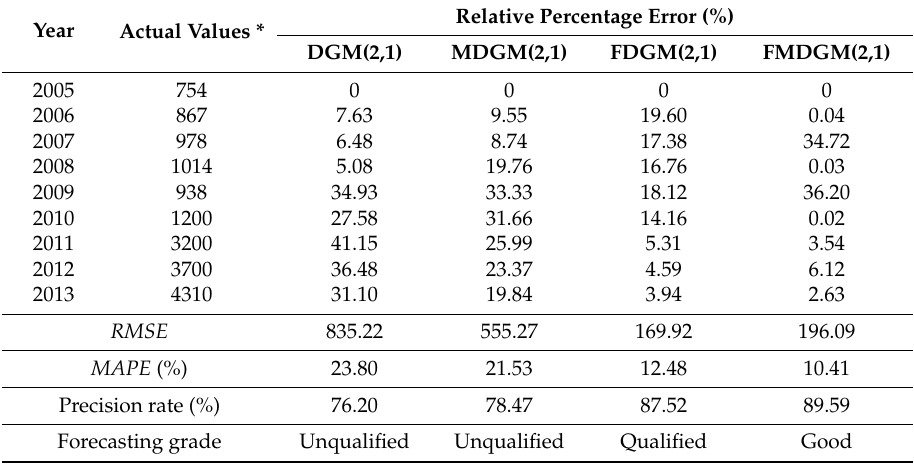
Table 2. Forecasting results for the revenues of Thailand’s medical tourism